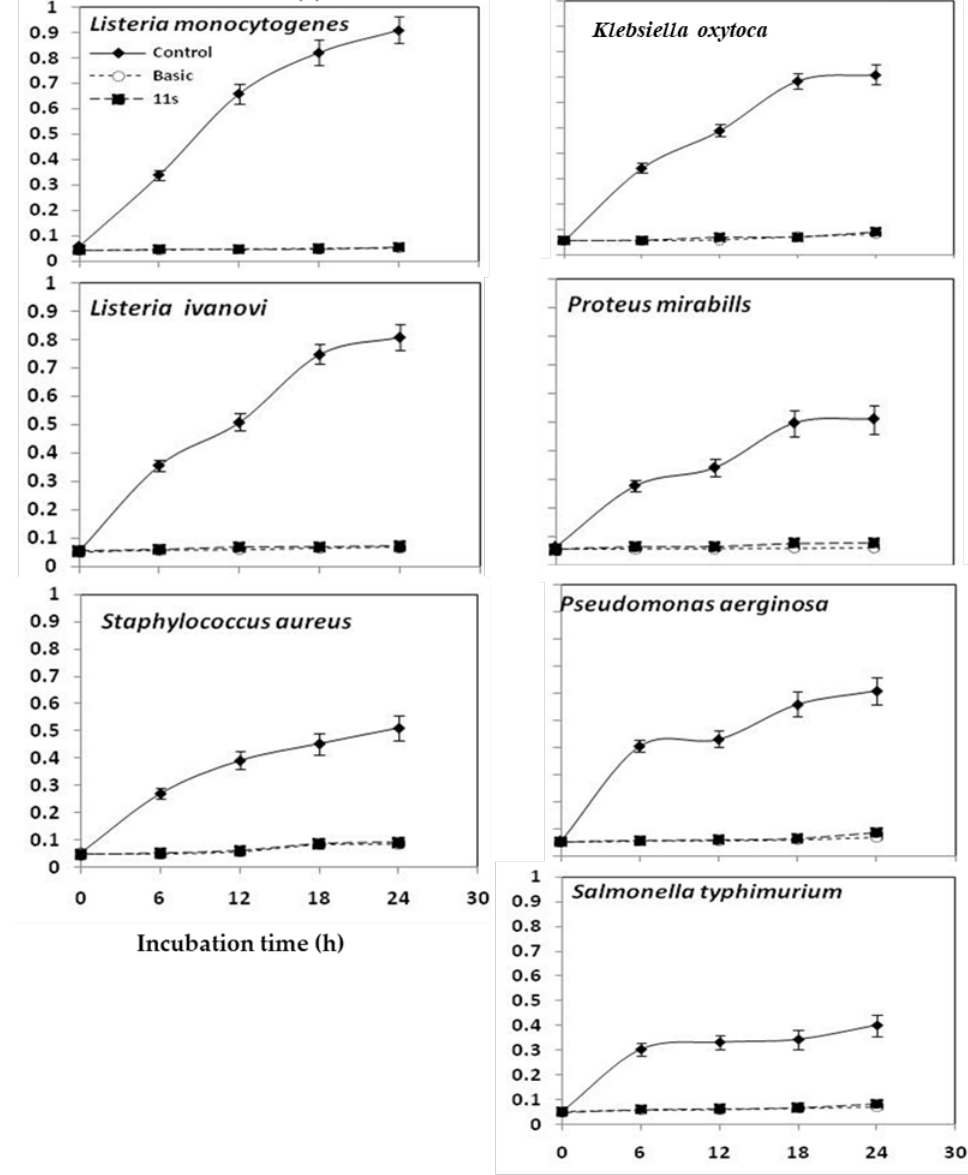
Figure 9. Twenty-four-hour growth curves of three pathogenic Gram-positive bacteria and four pathogenic Gram-negative bacteria in the presence of MICs of 11S globulin and BS.